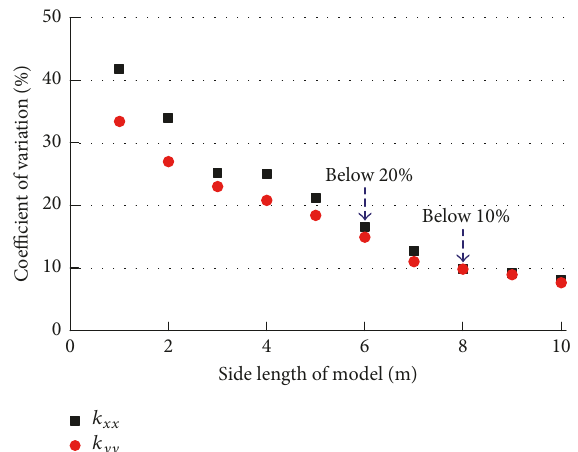
Figure 22: The values of coefficients of variation of 𝑘 𝑥𝑥 and 𝑘 𝑦𝑦 with increasing side lengths in the Darcy